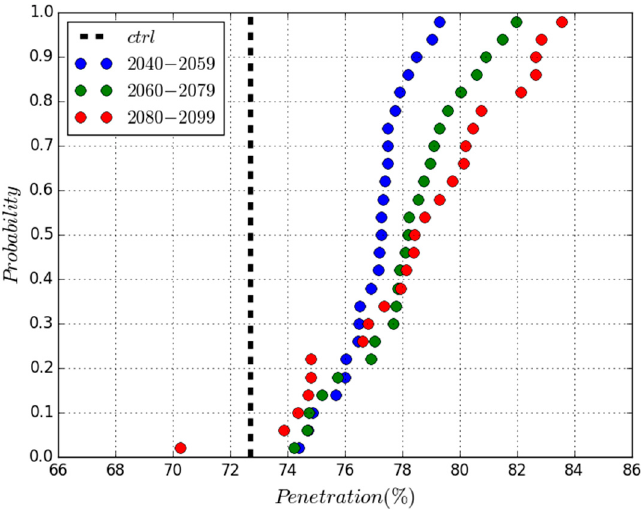
Figure 10. Cumulative distribution function (CDF) of penetration rate based on GCM projections (plotting position formula). The considered energy mix is defined by S PV = 0.25 and S H = 0.75. The dash line represents the penetration rate during the control period. Probabilities are computed using position-plotting formula by Hazen [60].